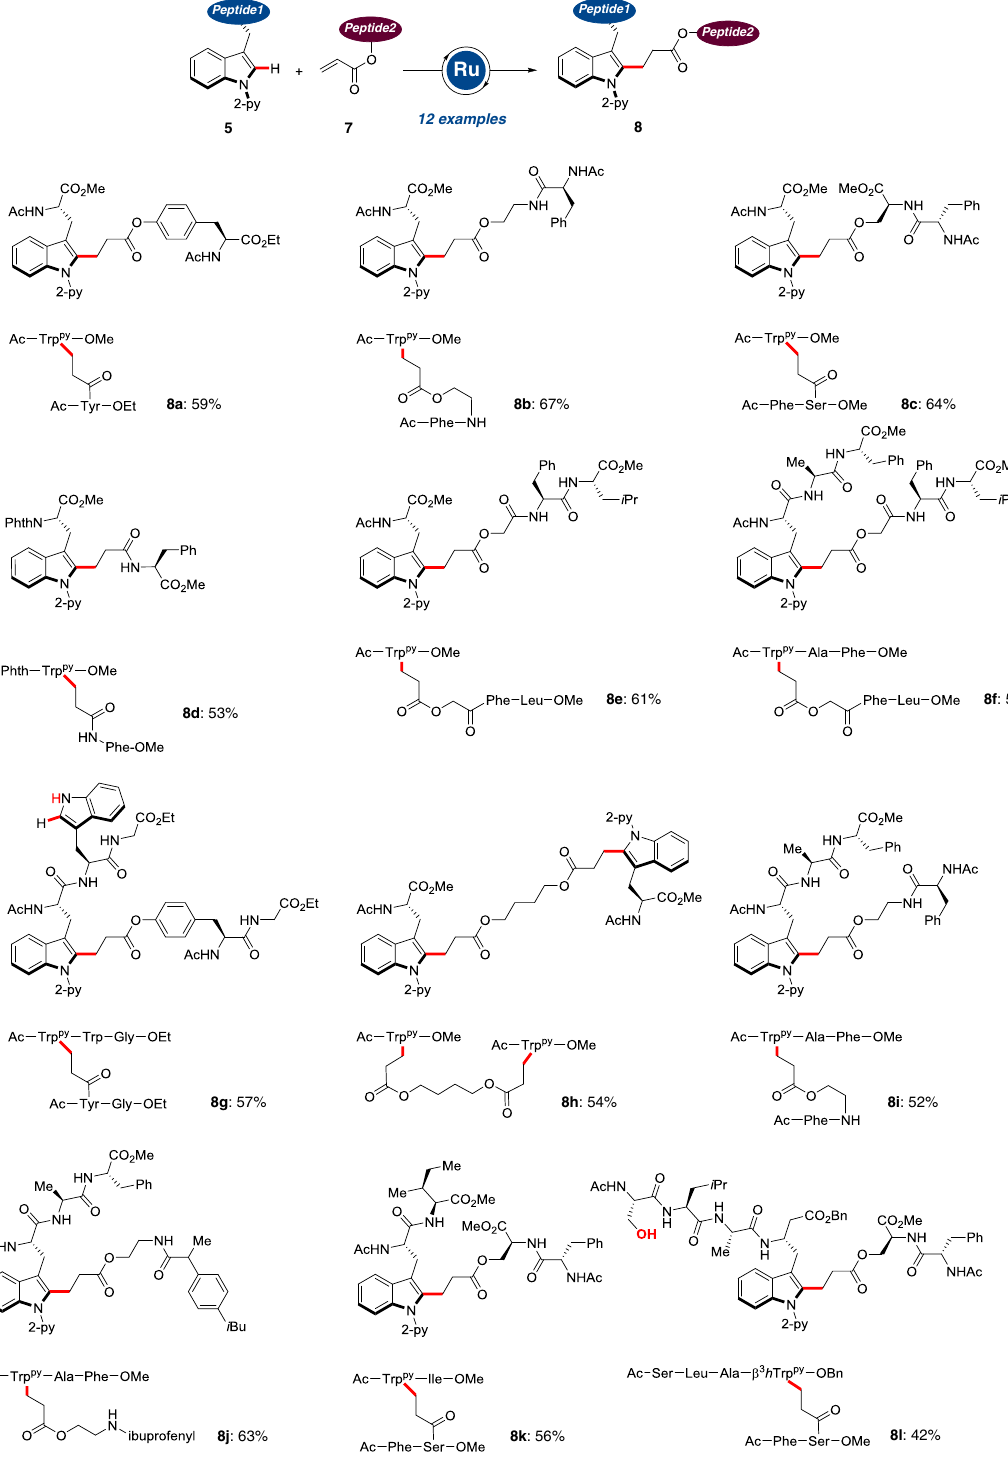
Fig. 5 Peptide ligation via C – H functionalization. Ruthenium(II)-catalyzed C – H alkylation, occurring without racemization including β -peptides and twofold C – H